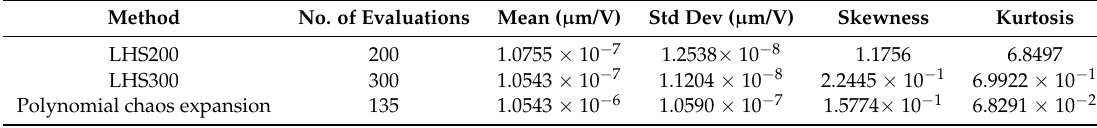
Table 8. Moments of maximum deflection estimated using different Uncertainty Quantification (UQ)